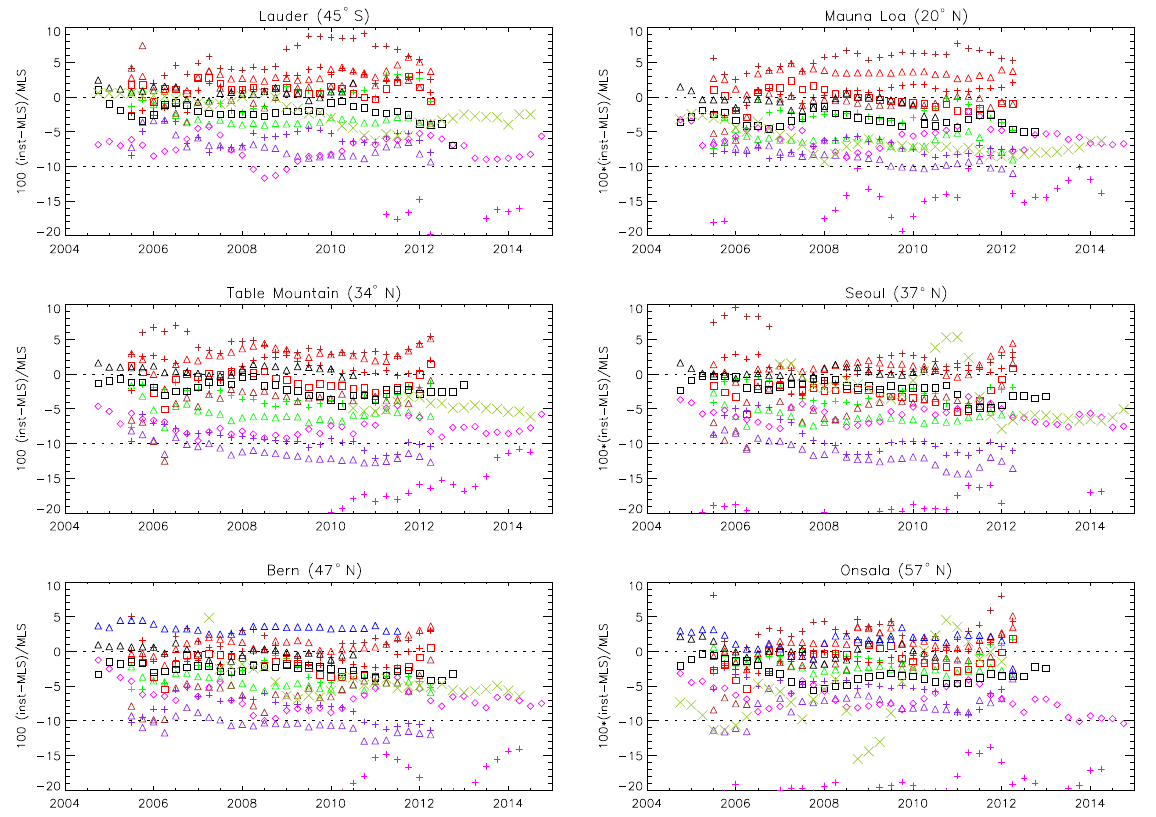
Figure 5. Annual average differences between coincident H 2 O measurements at 0.46hPa. Results are shown at six ground-based sites and all differences are with respect to MLS measurements at those sites. Annual average differences are shown four times per year (see text). The symbols used are from Fig. 1 and indicate the instrument that is being compared with